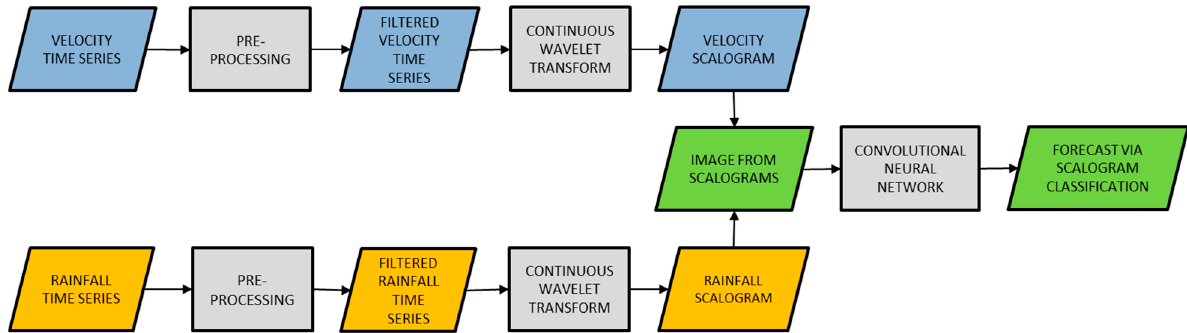
Figure 1. Flowchart of the proposed procedure aimed at providing velocity forecasts from rainfall and velocity data.